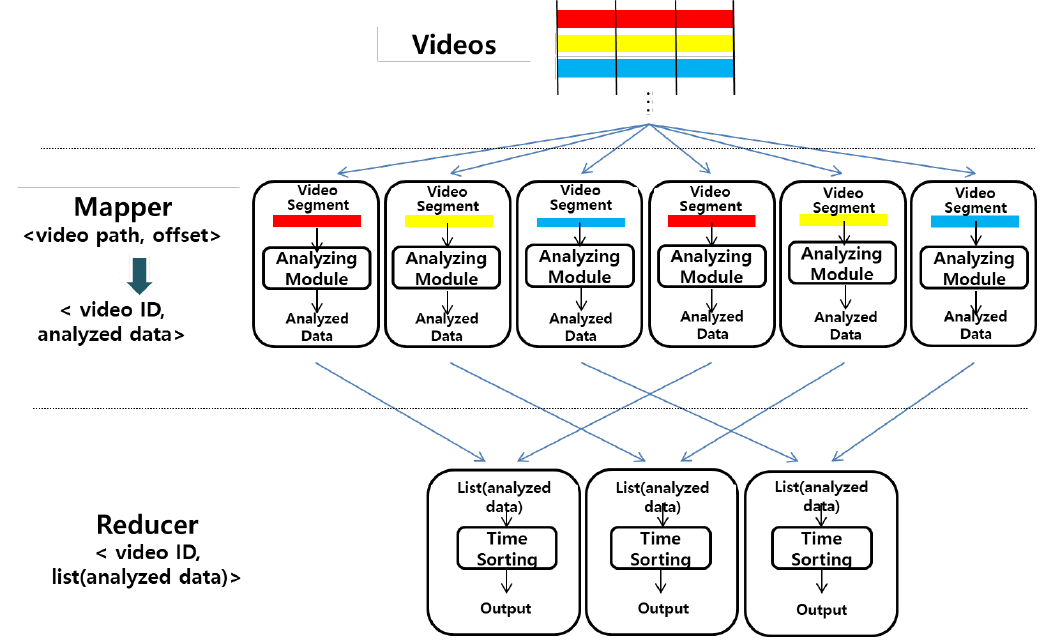
Figure 4. The video data processing by the MapReduce Analyzer.